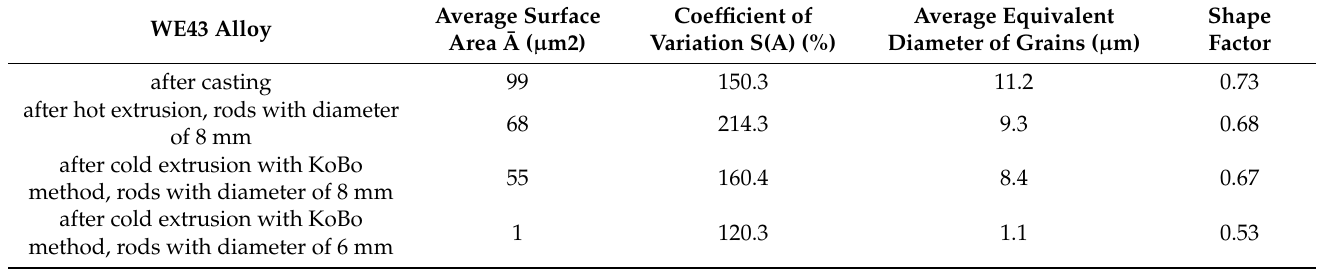
Figure 3. Microstructure of WE43 alloy after casting process and solution heat treatment. Table 2. Results of quantitative characterization of the WE43 alloy after applying the KoBo method